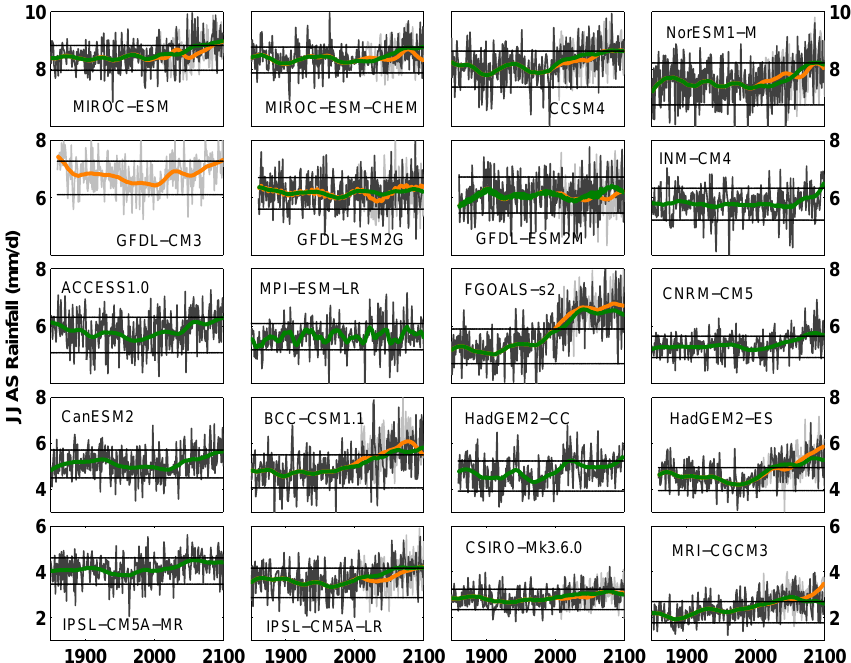
Fig. 5. Long-term trend in seasonal mean rainfall, same as in Fig. 4, but for RCP-4.5 (green) and RCP-6.0 (orange) scenarios. Horizontal black lines represent the range of baseline variability as in Fig. 4. Please refer Table 1 for the data availability for Figs. 4 and 5.